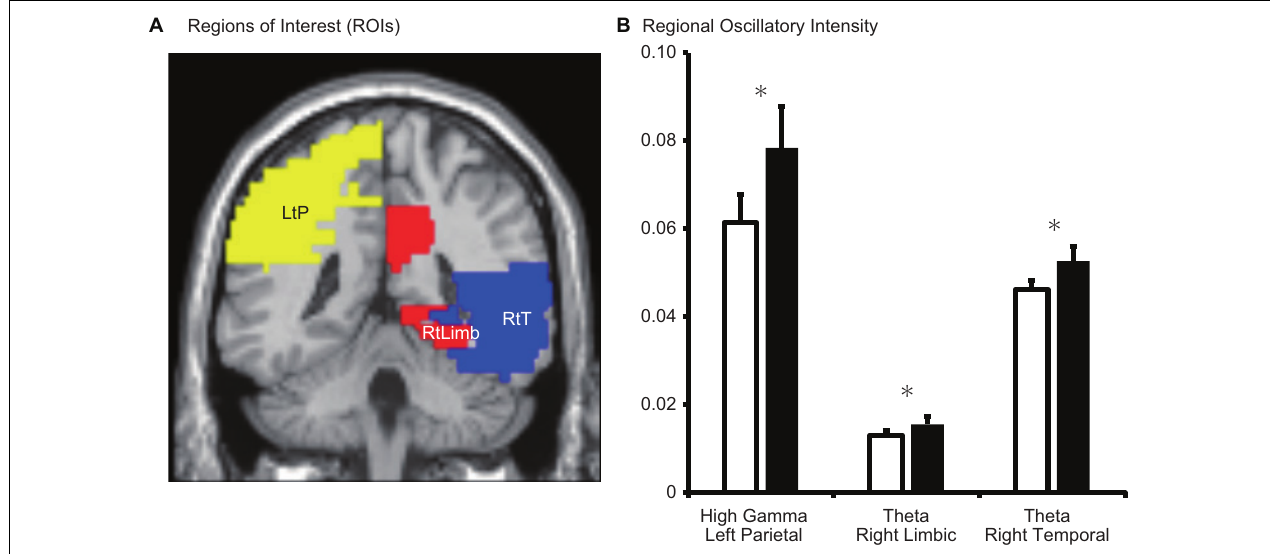
FIGURE 5 | (A) Schematic representation of regions of interest (ROIs) and (B) regional oscillatory intensity changes during the menstrual period (MP, open columns) and the period outside of menstruation (OP, filled columns). Three parameters with significant changes (after false-discovery rate (FDR) correction) were displayed. Error bars represent the grand mean of standard errors over bootstrapped iterations. LtP, left parietal; RtLimb, right limbic system; RtT, right temporal. Asterisks (*) indicate statistically significant difference after FDR